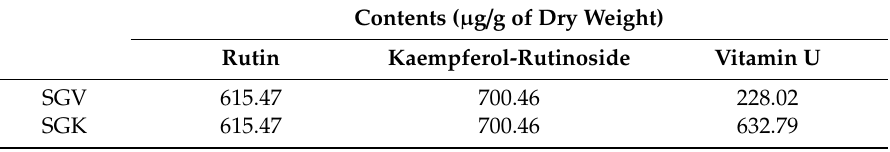
Table 1. Contents of bioactive components in steamed extract of graviola leaves (SGV) and SGV enriched with kale extract